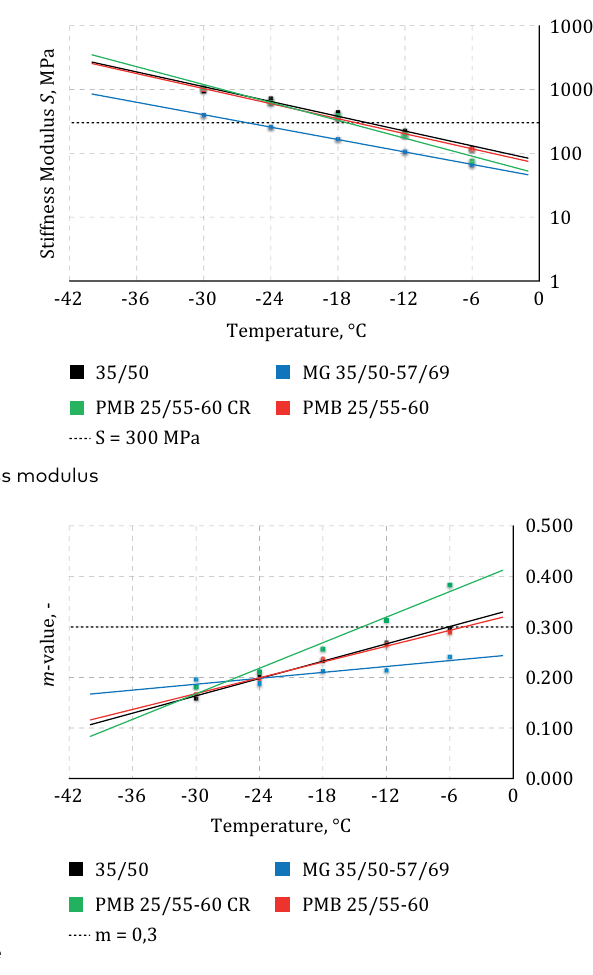
Figure 6. Stiffness modulus and m -value parameter at 60 seconds loading from the Bending Beam Rheometer test versus temperature for medium consistency